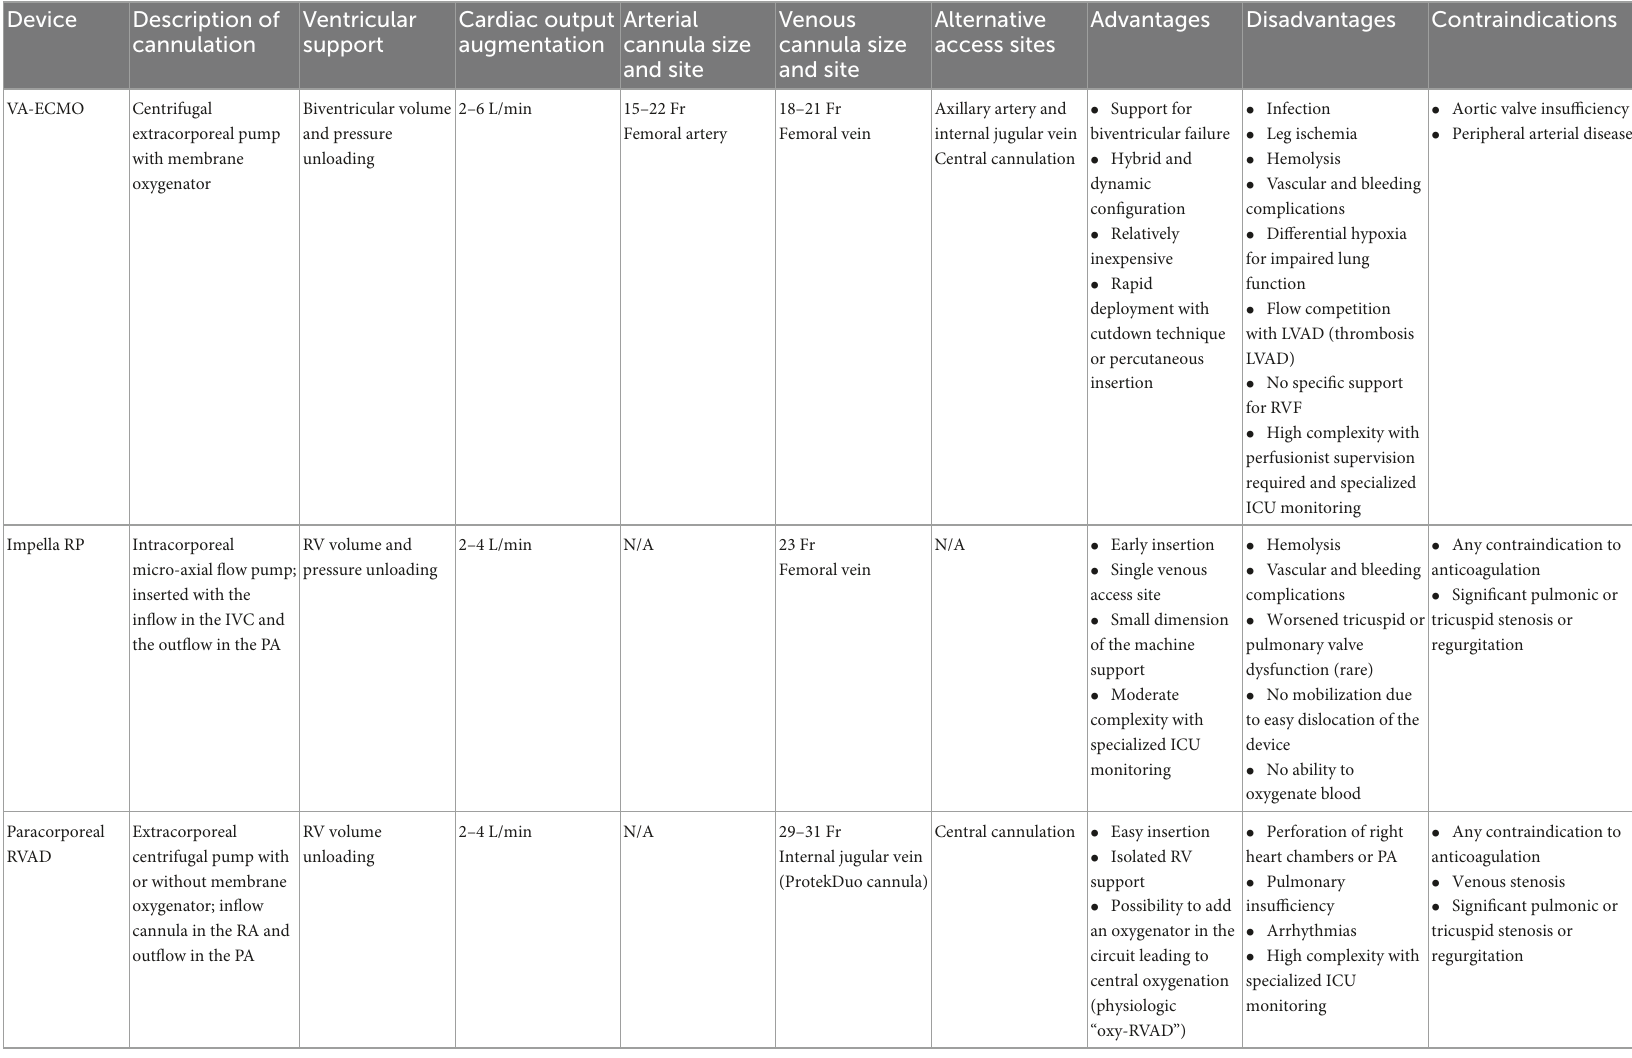
TABLE 2 Temporary mechanical circulatory support devices for acute right ventricular